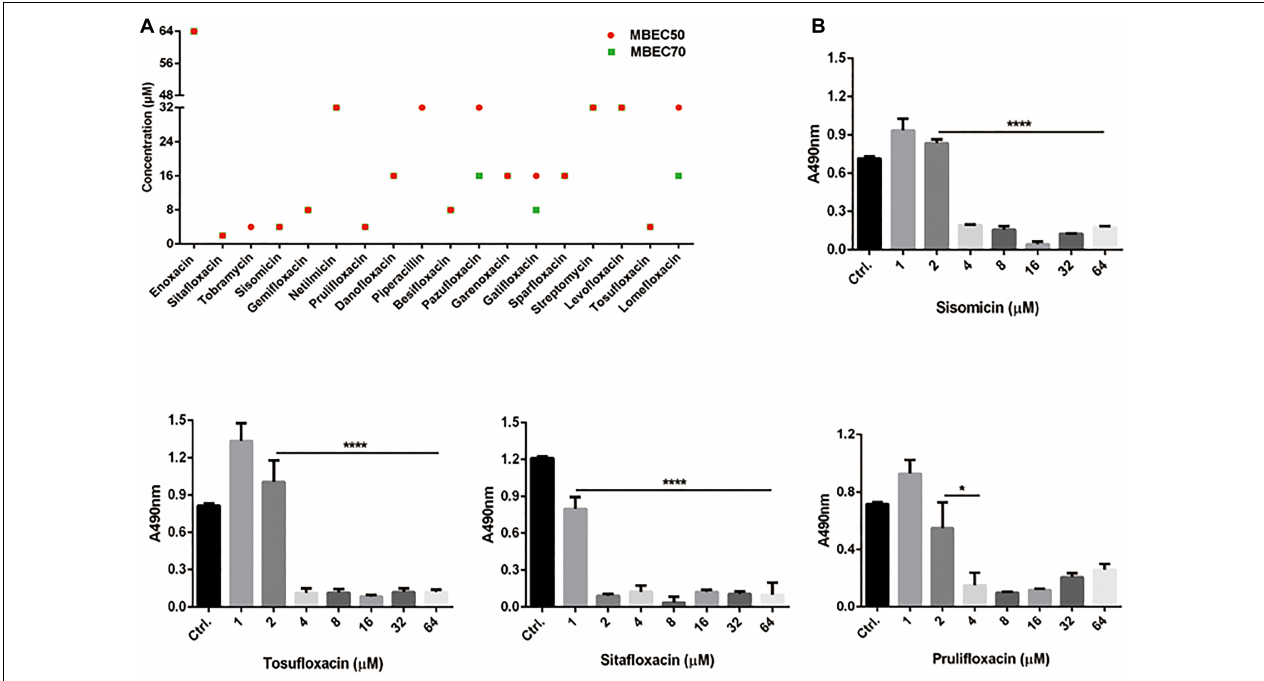
FIGURE 1 | Minimum biofilm eradication concentrations of drugs against P. aeruginosa PAO1 Biofilms. (A) Biofilm eradication by selected drugs detected by XTT assay. Biofilms cultured for 24 h were treated with selected drugs at the specified concentrations. After incubation, removed planktonic cells and stained biofilms with XTT/PMS solution. The red circle and the green square represent the MBEC50 and MBEC70 of 18 drugs, respectively. (B) The effect of representative drugs on the biofilm eradication of PAO1, data representing three independent experiments performed in duplicate. * P < 0.05; **** P < 0.0001.